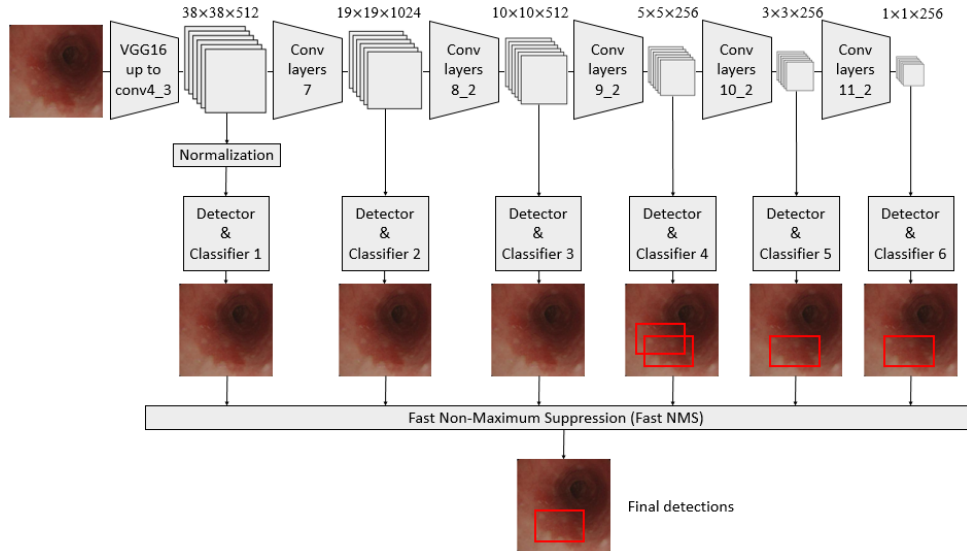
Figure 1. Schematic flowchart of the single-shot multibox detector (SSD) for esophageal neoplasms. Under the input of 300 × 300 SSD, Conv7, Conv8_2, Conv9_2, Conv10_2, and Conv11_2 were extracted as the feature maps for detection in the newly added convolutional layer to generate more layers with smaller scales and facilitate multilayer feature fusion. A total of six feature maps whose sizes were (38, 38), (19, 19), (10, 10), (5, 5), (3, 3), and (1, 1) were extracted with the Conv4_3 layer.